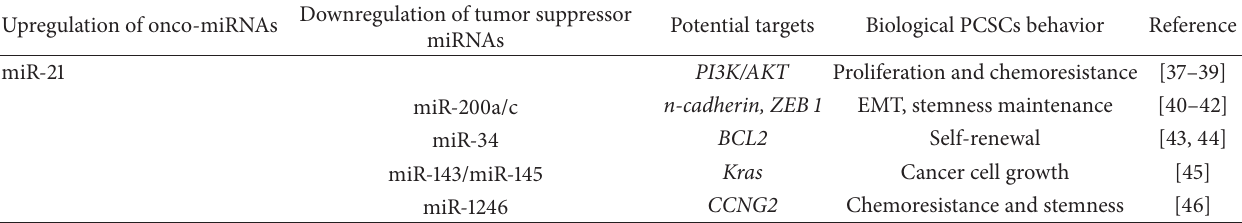
Table 2: The regulatory functions of miRNAs on PCSCs